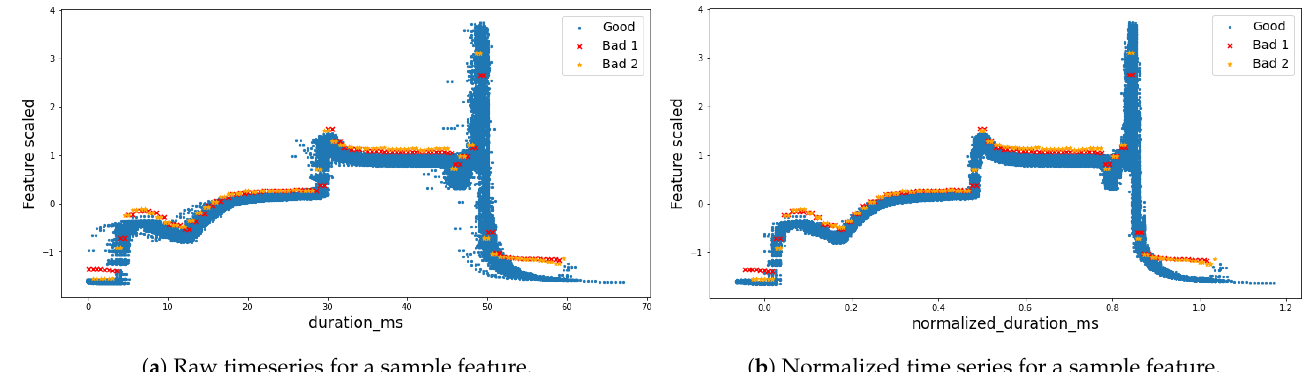
Figure 1. Time preprocessing: ( a ) the original raw time series and ( b ) the normalized representation, given a sample feature. Notice how, thanks to time preprocessing, the good samples are clustered together in a more compact baseline, while outliers are more separated from the